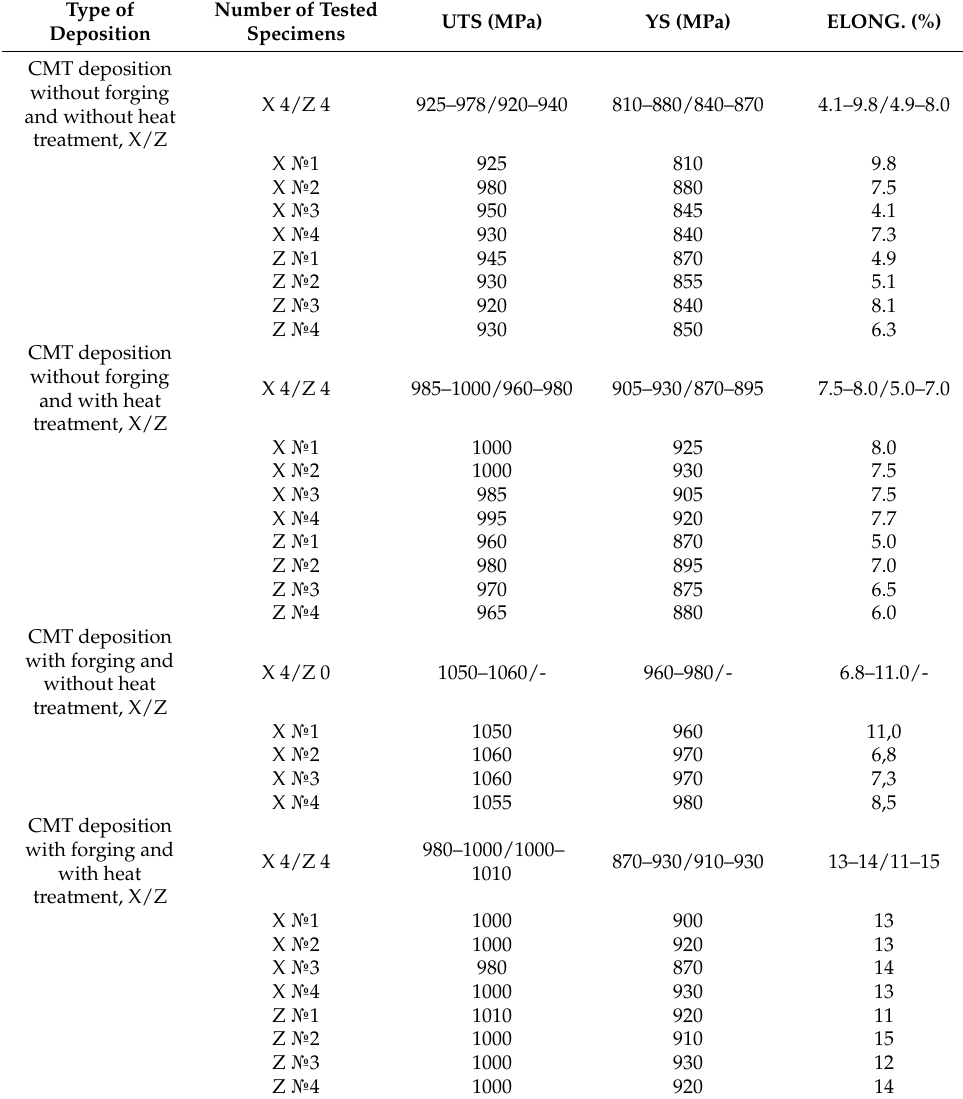
Table A1. The representative tensile test